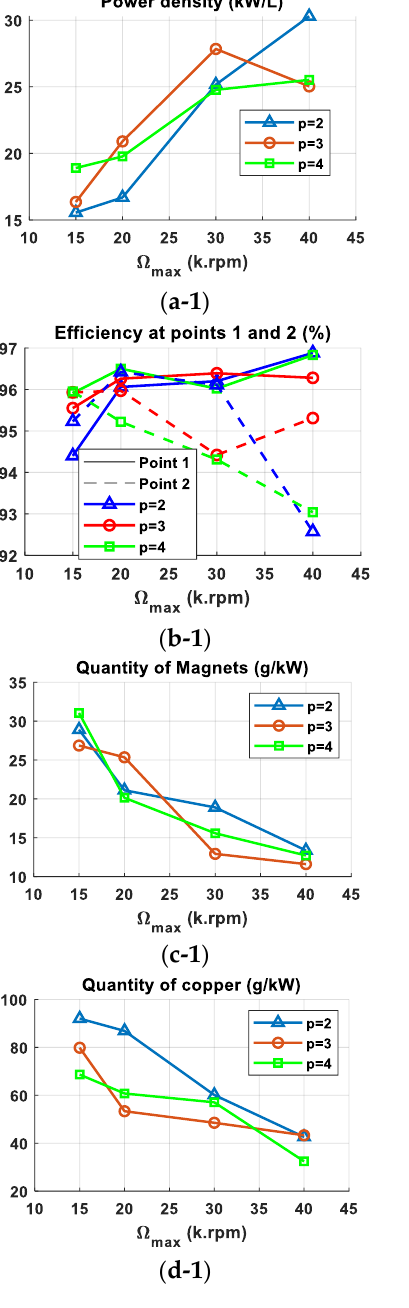
Figure 16. Characteristics of optimal CT-based machines: ( a-1 ) Power density, ( b-1 ) efficiency at points 1 and 2, ( c-1 ) quantity of magnets, ( d-1 ) quantity of copper; and Characteristics of optimal NT-based machines: ( a-2 ) Power density, ( b-2 ) efficiency at points 1 and 2, ( c-2 ) quantity of magnets, ( d-2 ) quantity of copper